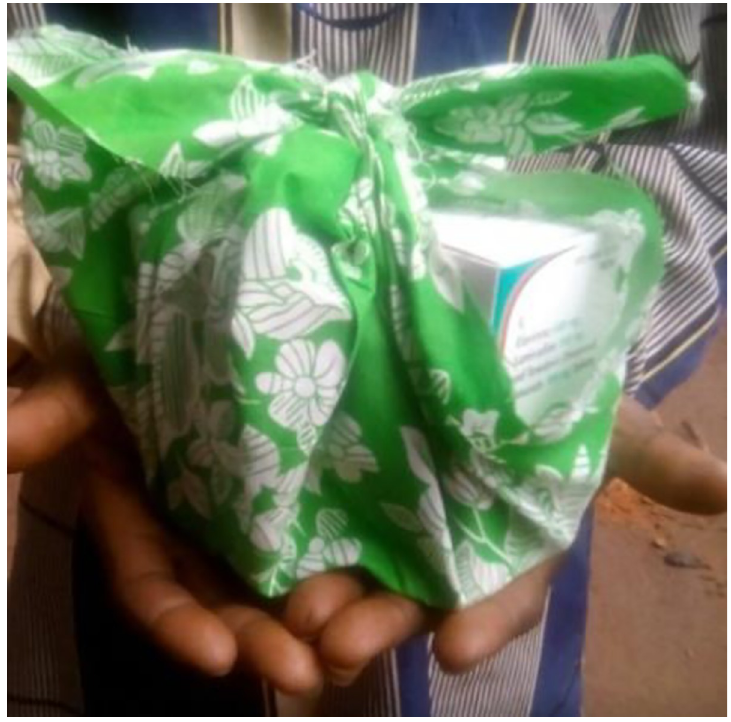
Fig 3. Run-away bags including 3 months of ARV’s for patients under contingency plan.